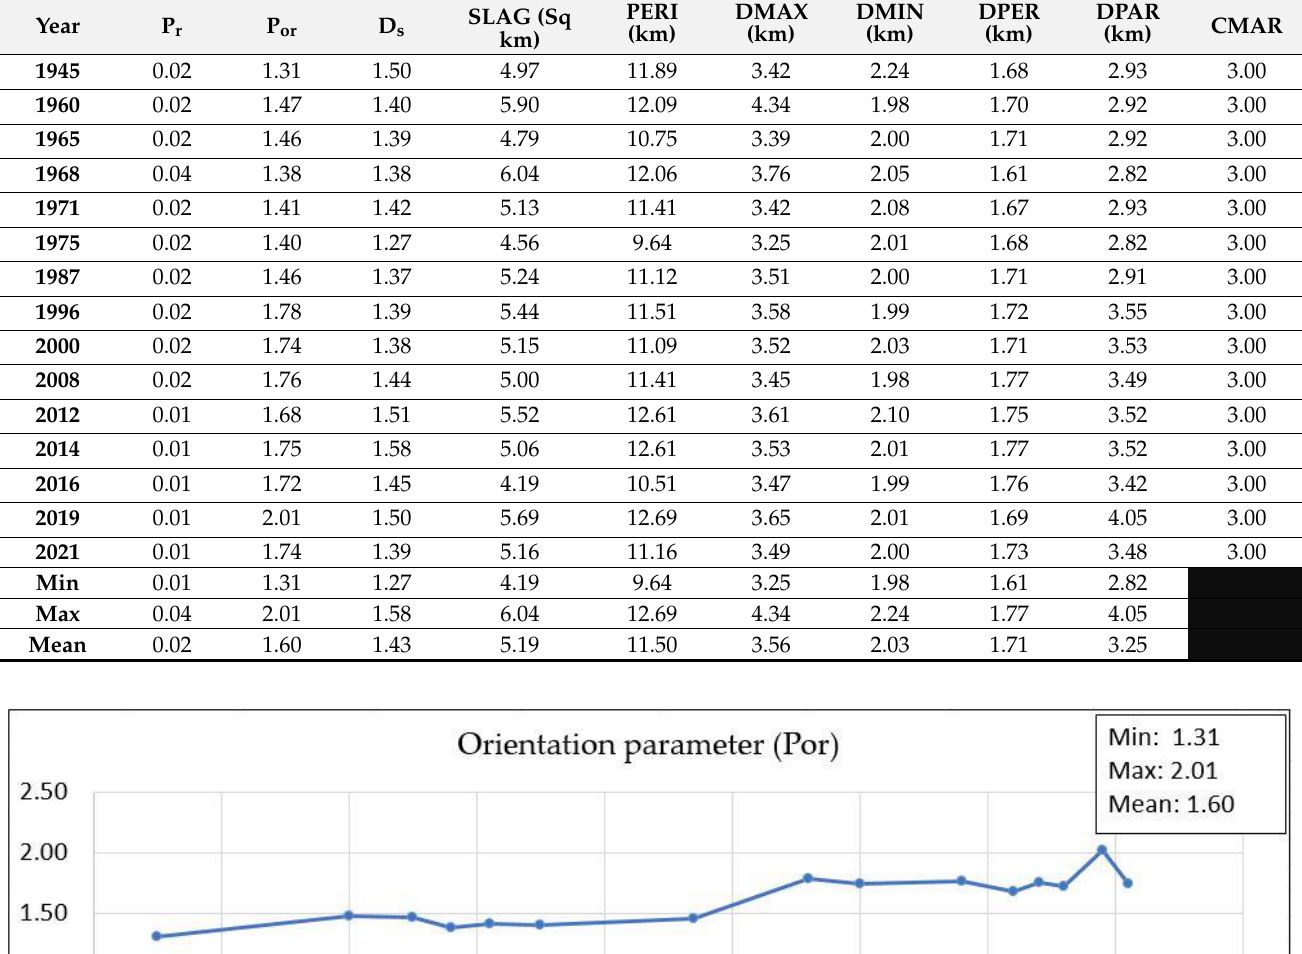
Table 3. Morphometric parameters of the Prokopos Lagoon.